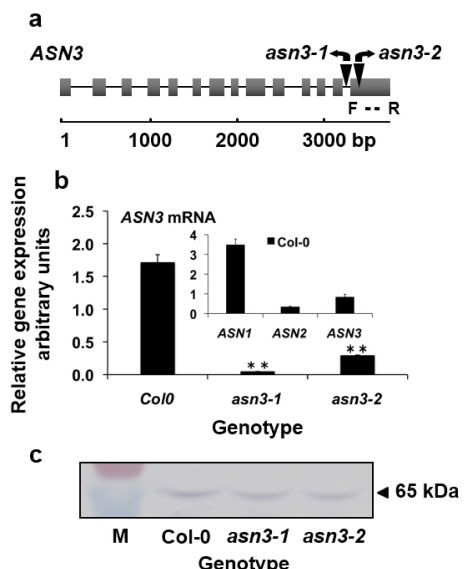
Figure 1. Characterization of asn3-1 and asn3-2 T-DNA insertion mutants using rosette leaves from 35-day-old Arabidopsis plants. ( a ) Schematic presentation of the T-DNA insertion site within the ASN3 gene of the asn3-1 (intron 13) and asn3-2 (exon 14) lines; ( b ) ASN1 mRNA, ASN2 mRNA and ASN3 mRNA levels of wild-type (Col-0) (insert), and ASN3 mRNA levels in wild-type (Col-0), asn3-1 and asn3-2 lines; ( c ) Western blot showing asparagine synthetase protein in wild-type (Col-0), asn3-1 and asn3-2 lines. Boxes and lines in the gene structure correspond to exons and introns, respectively. Black triangles indication T-DNA insertions (the size is not to scale). ASN3 mRNA levels were measured by qPCR relative to Actin 2 (At3g18780) and expressed as the mean ˘ SE of three biological replicates. F and R represent forward and reverse primers, respectively. Asterisks indicate significant differences between the Col-0 and asn3 mutants using a Student’s t -test P -values ** p < 0.01. Molecular mass markers on the Western blot membrane (M) correspond to 55 kDa and 72 kDa (Thermo Fisher Scientific Inc, Villebon-sur-Yvette,